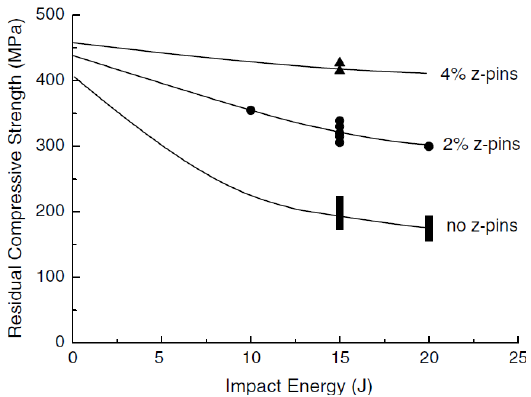
Figure 72. Post-impact compressive strength of composites with and without z-Pins